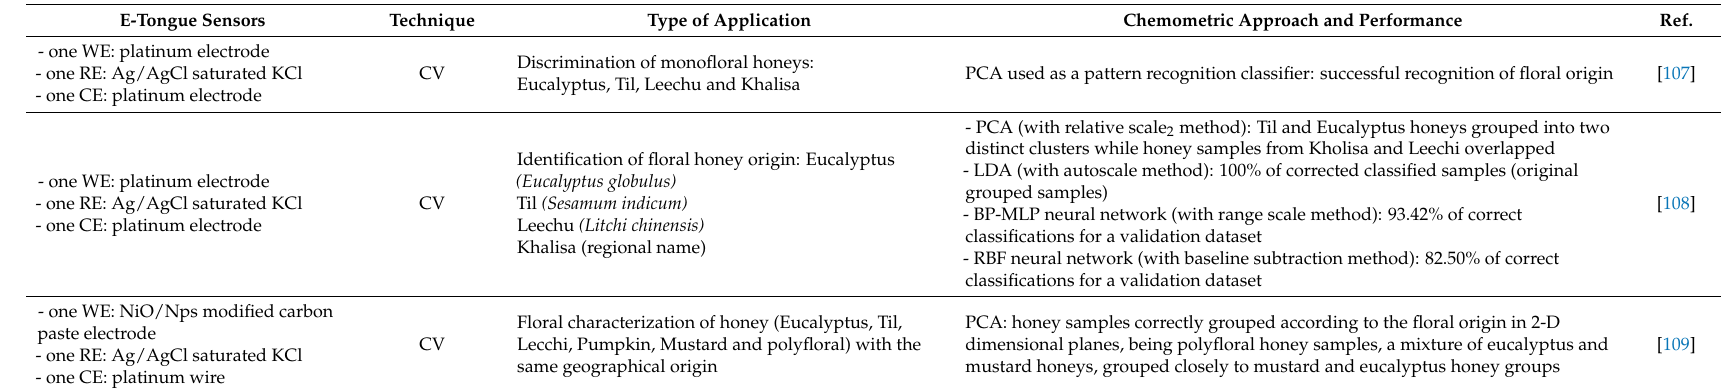
Table 4. Honey analysis using self-assembled lab-made conventional three-electrodes voltammetric